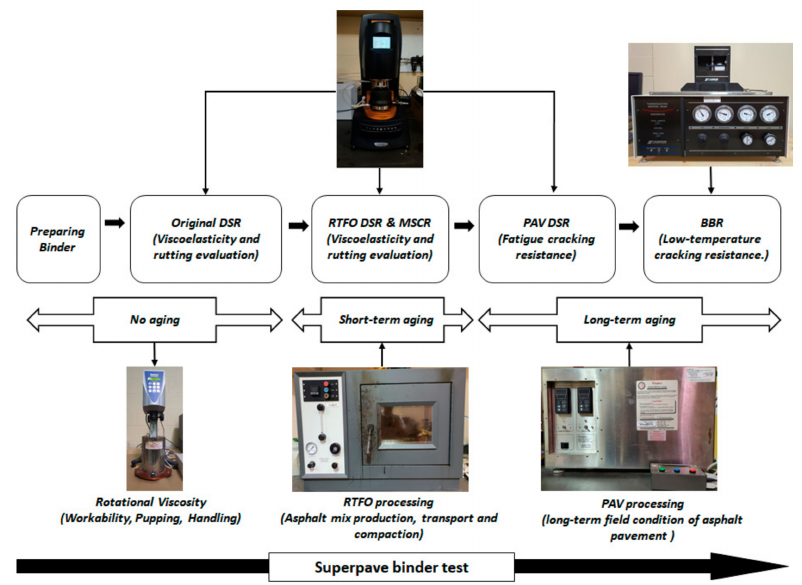
Figure 3. The procedure of Superpave binder